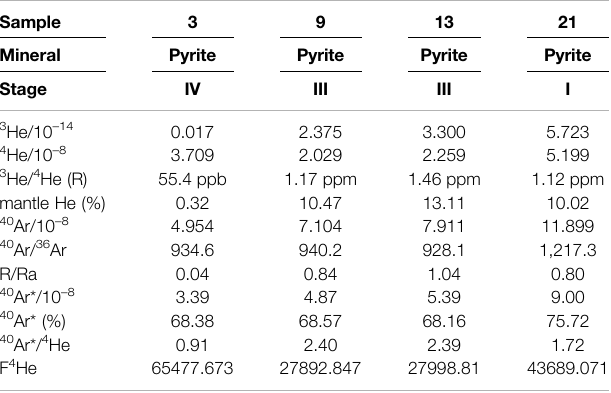
TABLE 5 | Fluid inclusion He-Ar isotopic compositions ofpyritefrom the Zhaoxian gold